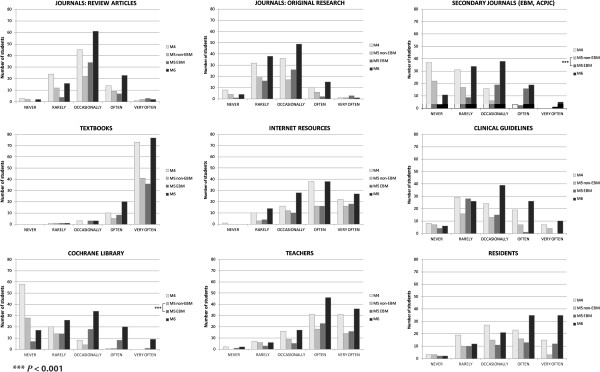
Use of evidence to keep up to date. Distribution of answers to the question: "what type of resources do you use to keep up to date?" in the different medical student groups. (M4=4th year students with no evidence-based medicine training; M5 EBM and M5 non-EBM=5th year medical students with and without the evidence-based medicine course; M6=6th year students exposed to the evidence-based medicine course during the year prior to assessment; EBM=Evidence-Based Medicine; ACPJC=American College of Physicians Journal Club). *** = P<0.001 Mann–Whitney U test for the M5 vs. M5 non-EBM comparison.